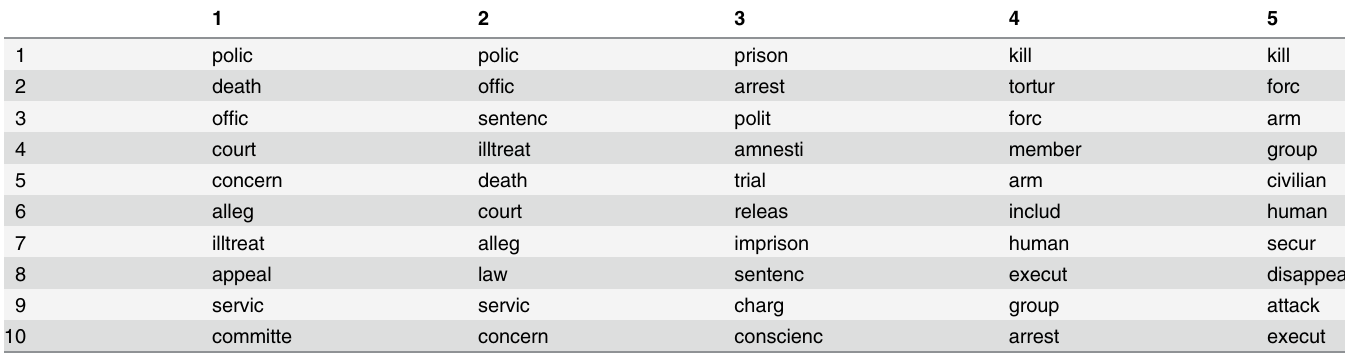
Table 1. Ten most important words for the PTS Amnesty International